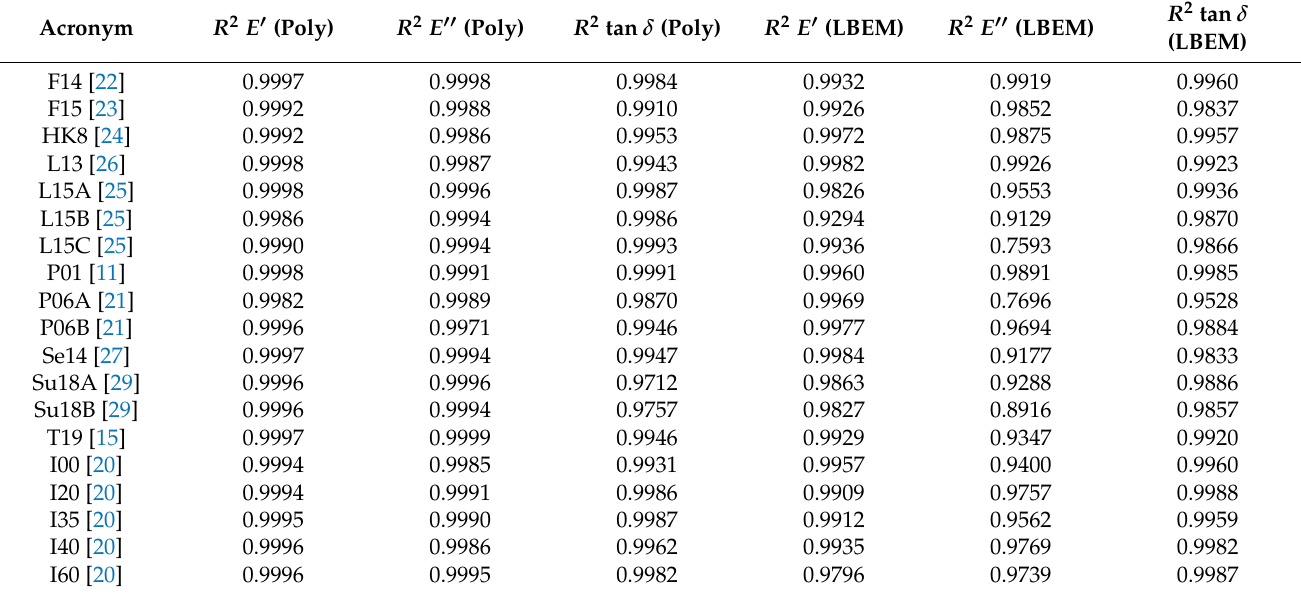
Table 4. Coefficient of determination for all the compounds using the polynomial and LBEM